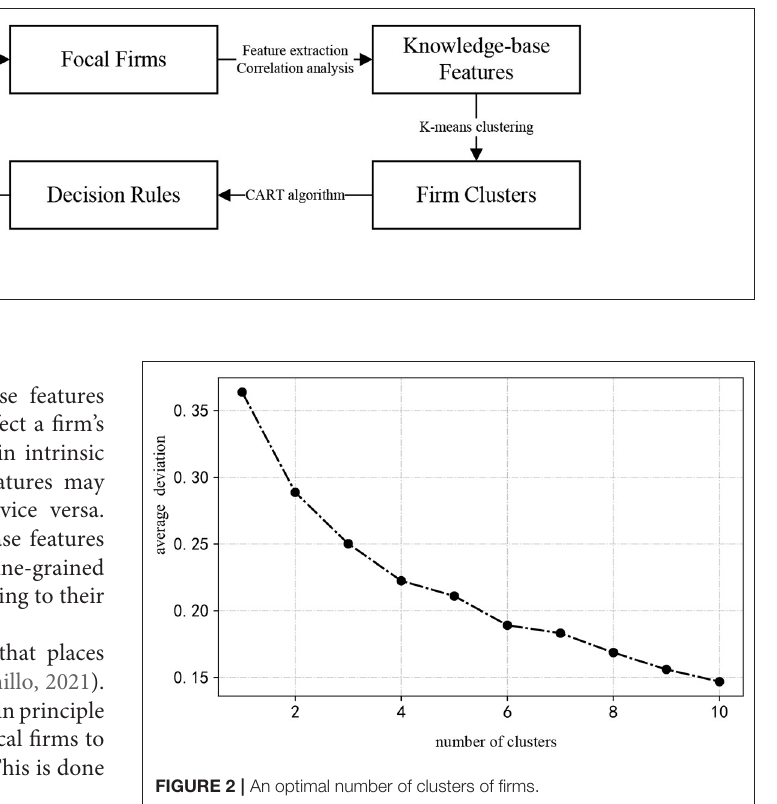
FIGURE 2 | An optimal number of clusters of